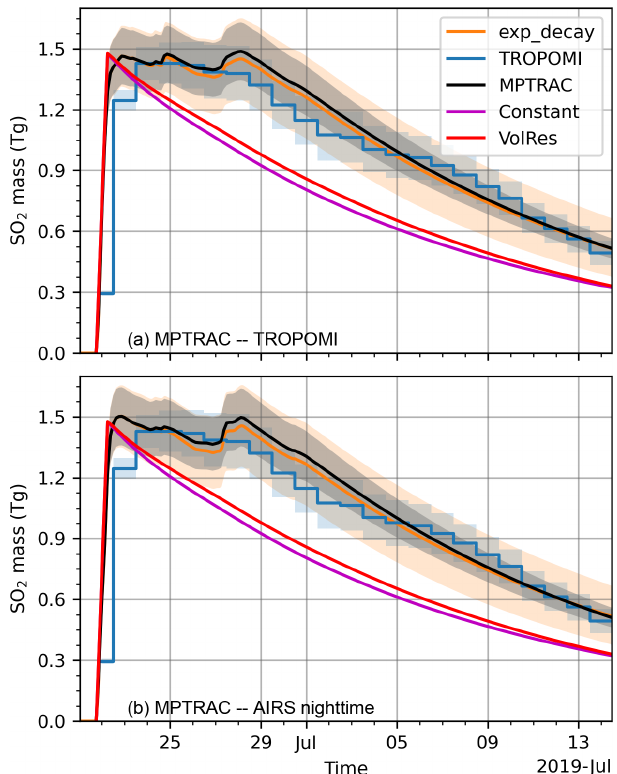
Figure 9. Temporal change of total SO 2 mass in the MPTRAC forward simulation (black lines) initialized by TROPOMI observa- tions (a) and AIRS nighttime observations (b) , respectively. Gray shadings show the range of total injection between 1.9 and 2.3Tg. Temporal changes of total SO 2 mass in the MPTRAC forward sim- ulations initialized by the VolRes profile (red) and a constant injec- tion rate (magenta) of 1.5Tg total injection are also plotted. In the forward simulations, the mass is derived from the chemistry mod- ule. The mass changes measured by TROPOMI (blue) and modeled by an exponential decay (orange) from Fig. 6 are repeated here for